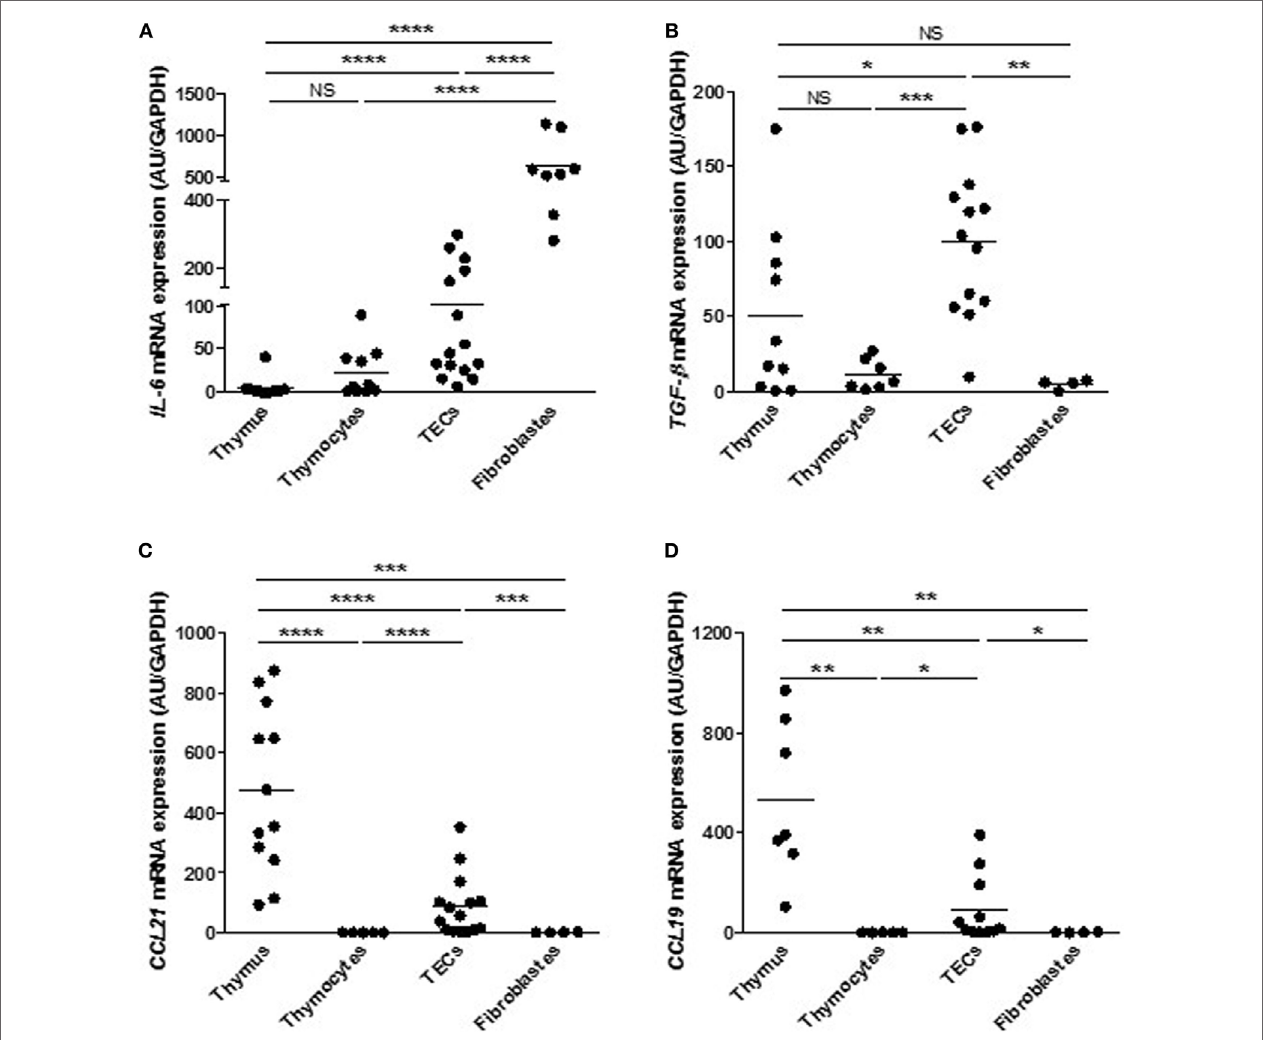
FIgURe 4 | Primary cultured human thymic epithelial cells (TECs) express cytokines and chemokines. Comparison of mRNA levels of interleukin 6 ( IL-6 ) (A) , tumor growth factor- β ( TGF- β ) (B) , CCL21 (C) , and CCL19 (d) in different thymic cell types. mRNAs were analyzed by real-time PCR and normalized to GAPDH . For each gene, mRNA expressions in primary TECs were normalized to 100 and compared with others cell types. mRNA expression levels are expressed as arbitrary units and are the mean values ( n > 6 for thymuses and n > 4 different donors for primary cultured TECs (day 7), fibroblasts or thymocytes). p Values were obtained using the Mann–Whitney test. Asterisks indicate significant differences (* p < 0.05, ** p < 0.01, *** p < 0.001, and **** p <